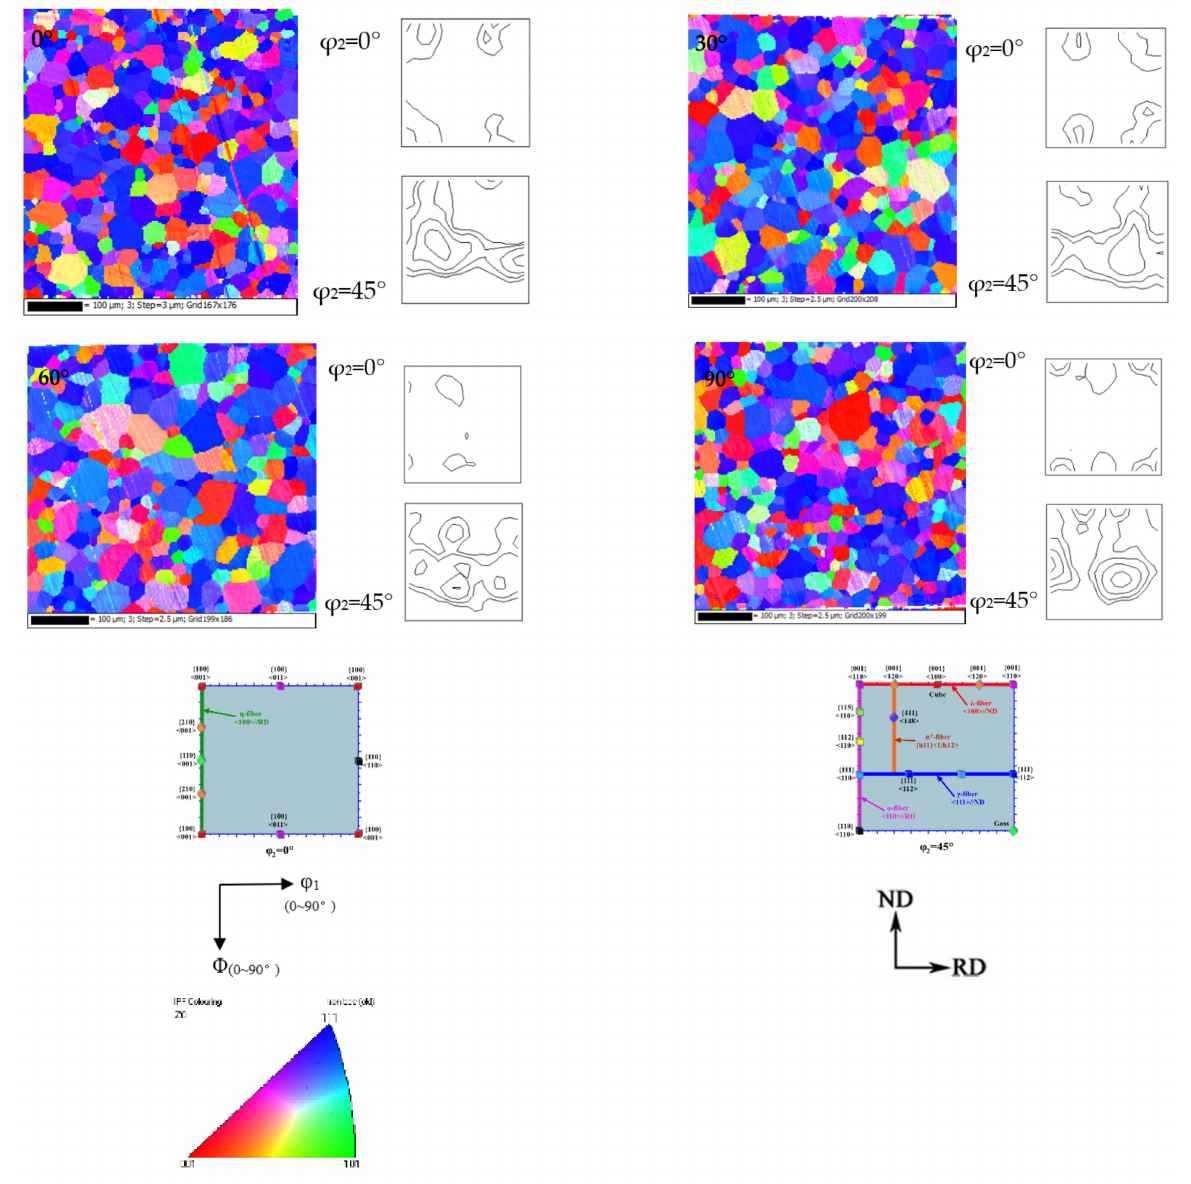
Figure 7. EBSD inverse pole figure (IPF) maps, ϕ 2 = 0 ◦ and ϕ 2 = 45 ◦ ODF section of Fe-0.65%Si annealed sheet with different angles to rolling direction, (levels: 1, 2, 4,